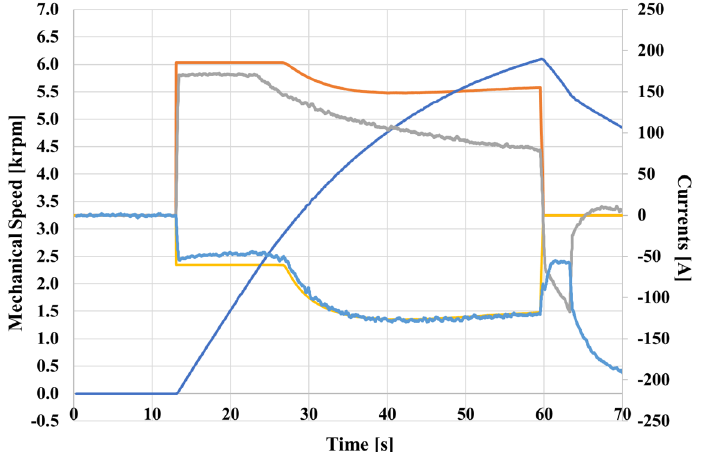
Figure 10. Experimental results of outer voltage control [17]. Angular mechanical speed profile (blue solid line) and d − q currents signals: i sd setpoint (yellow solid line), motor i sd (light blue solid line), i sq setpoint (orange solid line) and motor i sq (grey solid